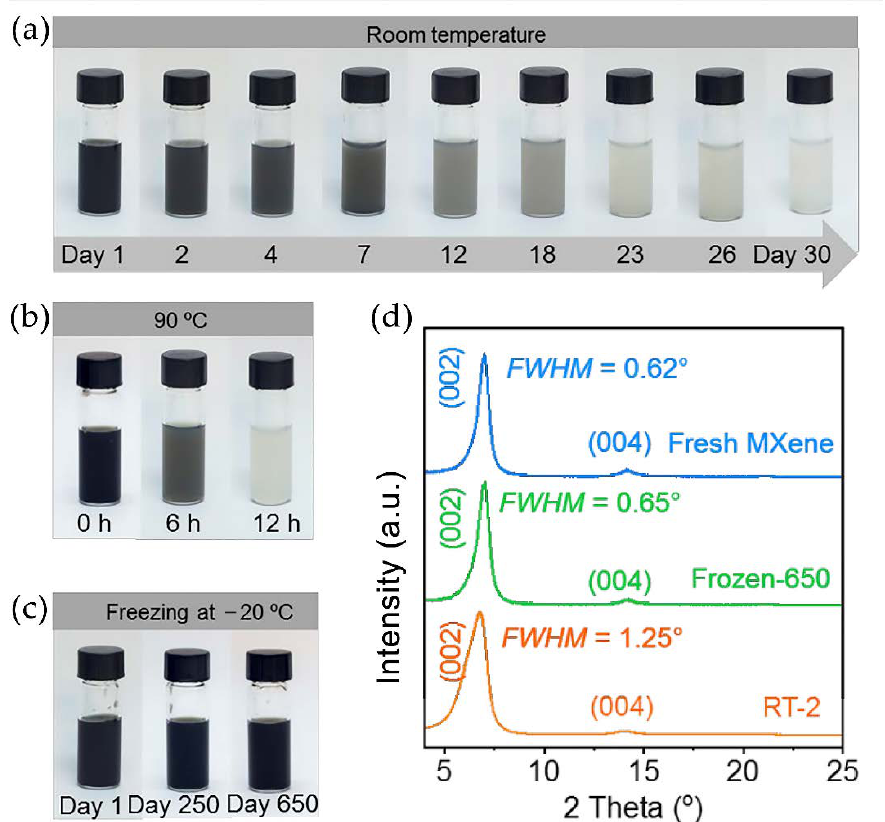
Figure 24. Photographs of an aqueous dispersion of Ti 3 C 2 T x (0.5 mg/ml) showing the effect of temperature on the oxidation rate of MXene: ( a ) color change when the aqueous dispersion is stored at room temperature for 30 days, ( b ) at 90 ◦ C for 0, 6, and 12 h, and ( c ) at − 20 ◦ C for 250 and 650 days. ( d ) X-ray diffraction patterns of MXene films obtained from Mxene dispersions immediately after synthesis, frozen at − 20 ◦ C after 650 days of storage and Mxene held for 2 days at room temperature. Reprinted with permission from [113] 2020 American Chemical Society.